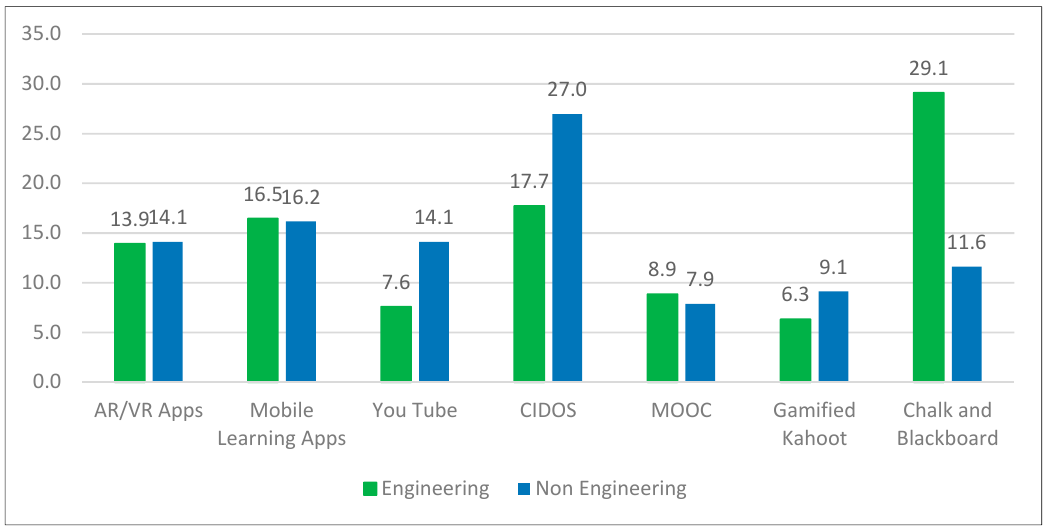
Figure 4. Students’ demand for the use of digital learning platforms and tools by field of studies.